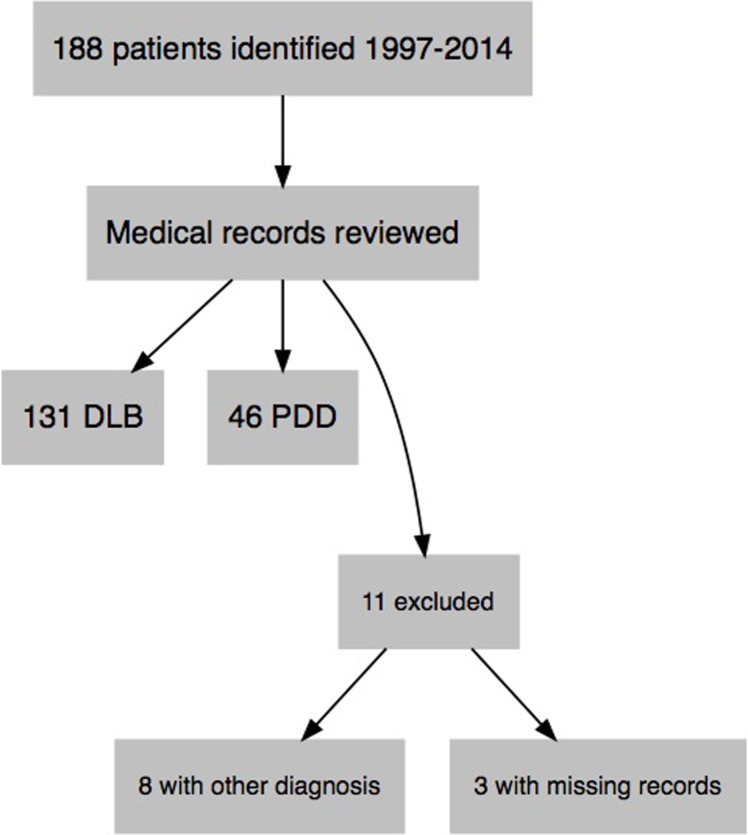
Patient flowchart.